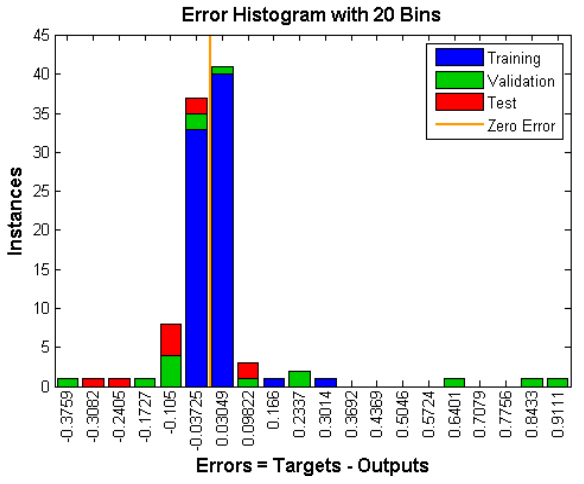
Figure 3. Error histogram.